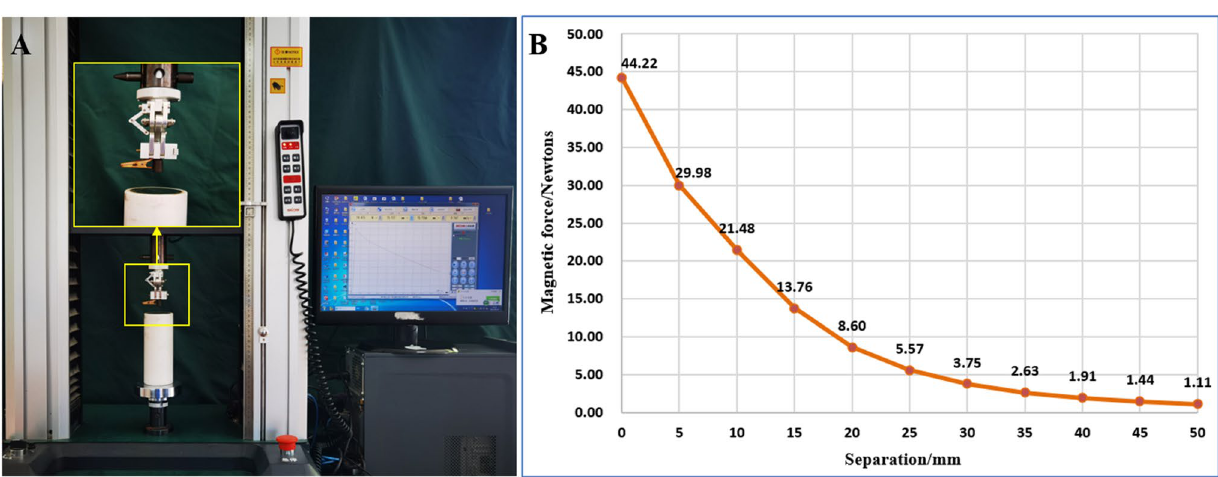
Figure 2. Measurement of magnetic force–displacement curve. ( A ) Schematic illustration of magnetic force– displacement curve measurement. ( B ) Magnetic force–displacement